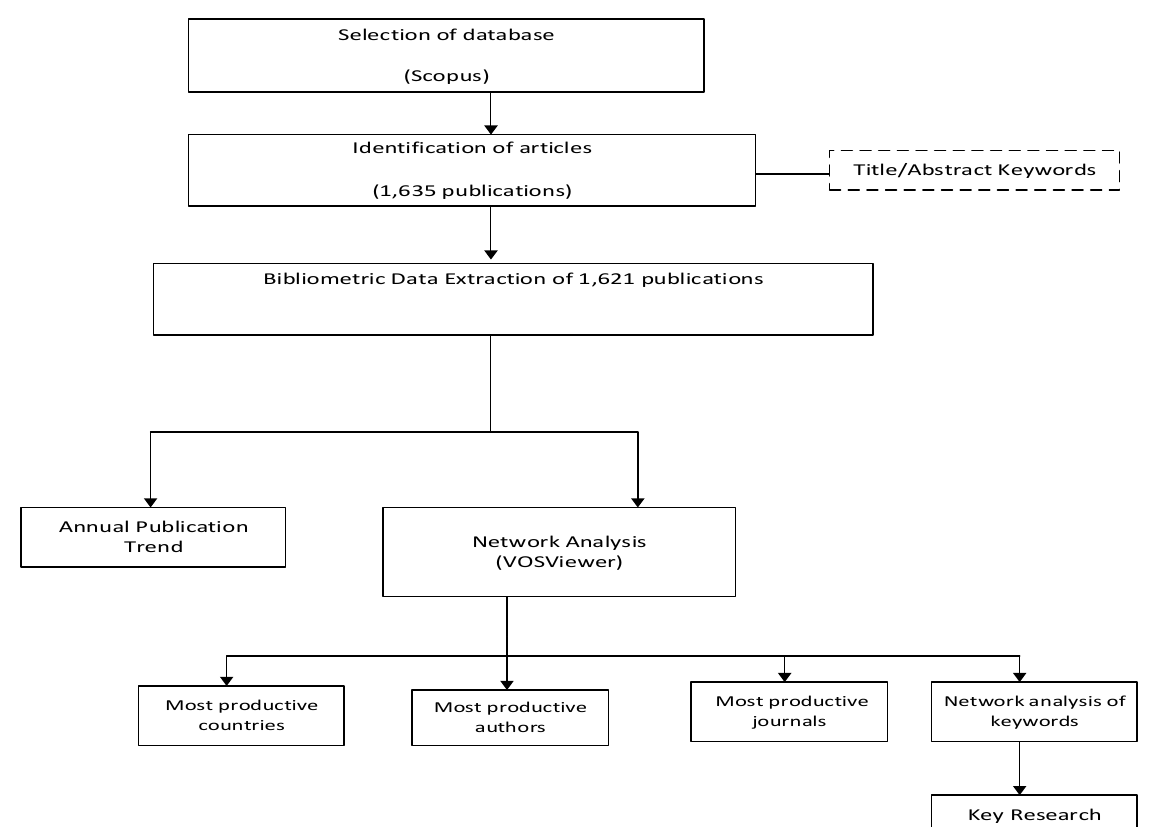
Figure 1. A flow chart of the research methodology.